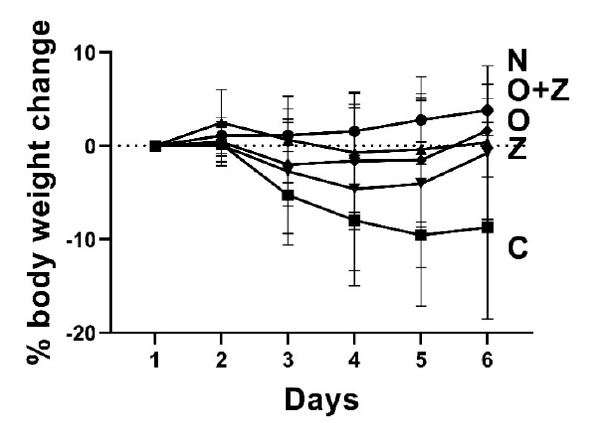
Figure 6. ZN27 does not change the gastric pH in the ongoing aspirin-induced gastric injury model. The gastric pH in the ZN27 ( n = 10, p > 0.05) group does not change, in comparison to the vehicle control ( n = 12) group. Omeprazole ( n = 9, *** p < 0.001) and omeprazole/ZN27 ( n = 8, ** p < 0.01) treatments increase gastric pH, in comparison to the vehicle control ( n = 12) group. The gastric pH after omeprazole/ZN27 treatment ( n = 8, ## p < 0.01) is significantly higher than in the ZN27 treated ( n = 10) group. Vehicle (C), omeprazole (O), ZN27 (Z), and omeprazole/ZN27 (O + Z). (n.s. means not statistically significant.)